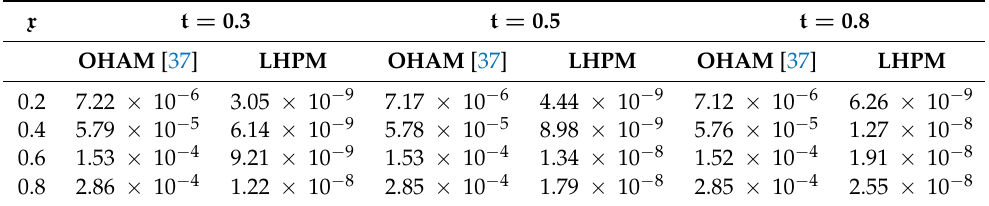
Table 8. Comparison of LHPM and OHAM errors in the Kaup–Kupershmidt equation (Example 4) at different t when β = 0.75, λ = 0.1, w = 1, ρ = 2.5 and µ = 0.